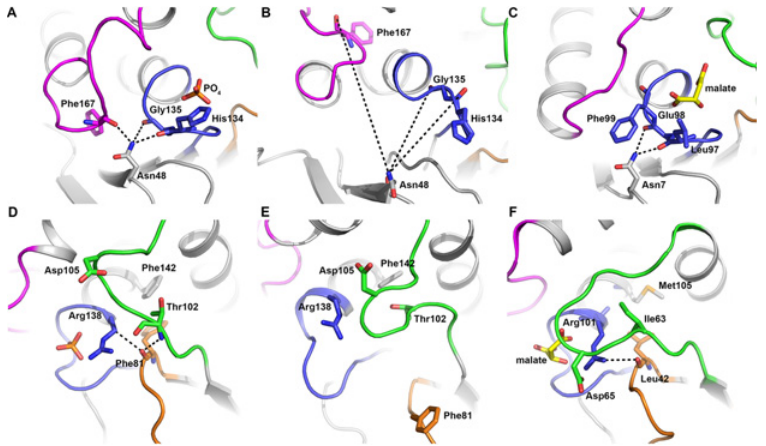
Fig 5. Structural changes in the PTP loop involving. (A) Asn48 in the ligand-bound TpbA structure, (B) Asn48 in the ligand-free structure (PDB ID: 2M3V), and (C) Asn7 in the structure of DUSP23 (PDB ID: 2IMG). Structural comparison of the general acid loop conformation in (D) the ligand-bound TpbA structure, (E) the ligand-free structure (PDB ID: 2M3V) and (F) the DUSP23 structure (PDB ID: 2IMG). Structures are coloured grey and functionally important loops are coloured as described in Fig